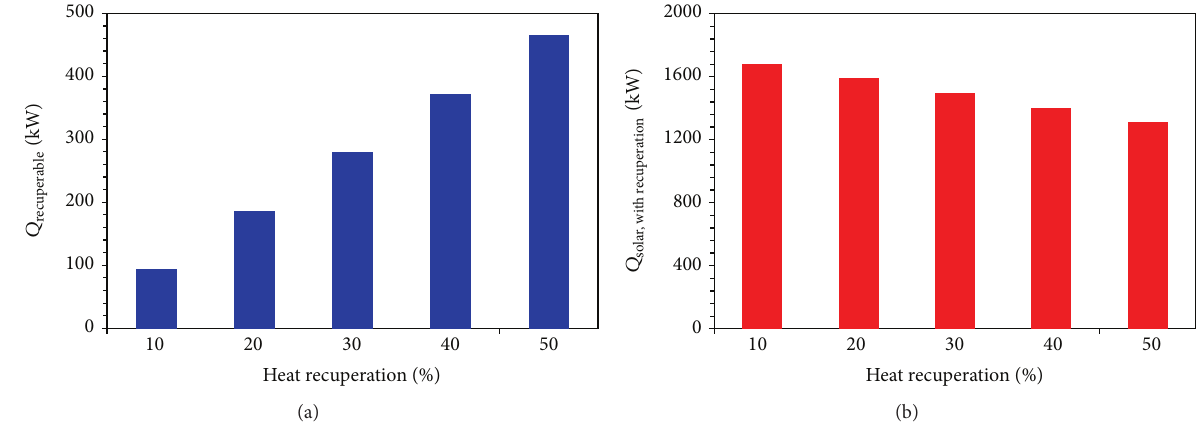
Figure 10: Effect of % heat recuperation on 𝑄